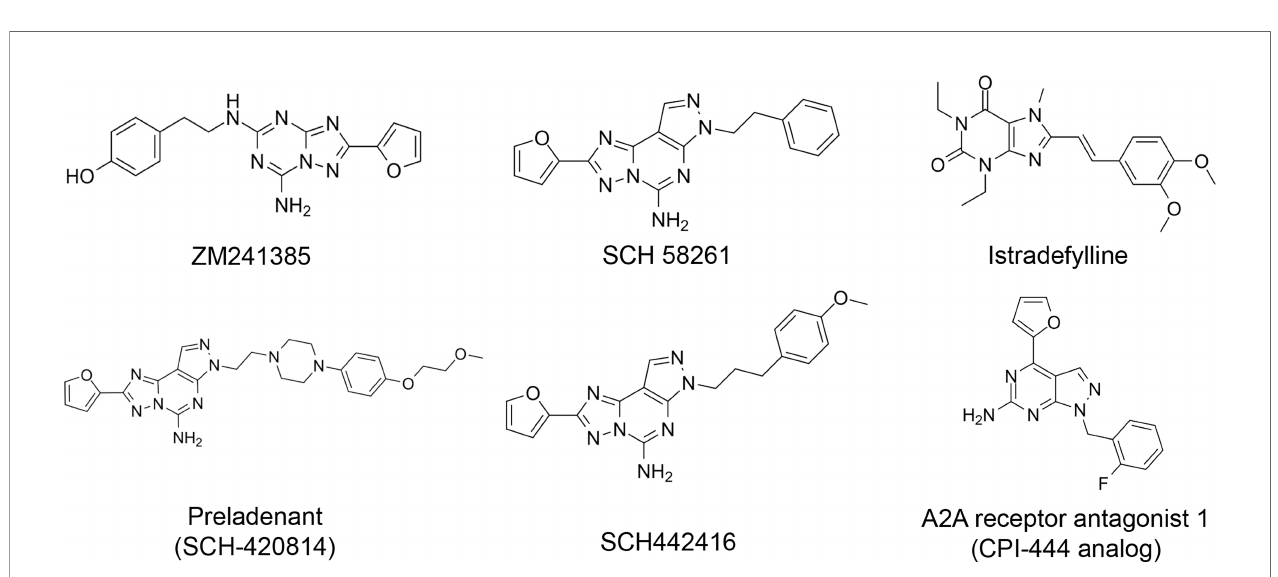
FIGURE 3 | High af fi nity and selective adenosine A2AR